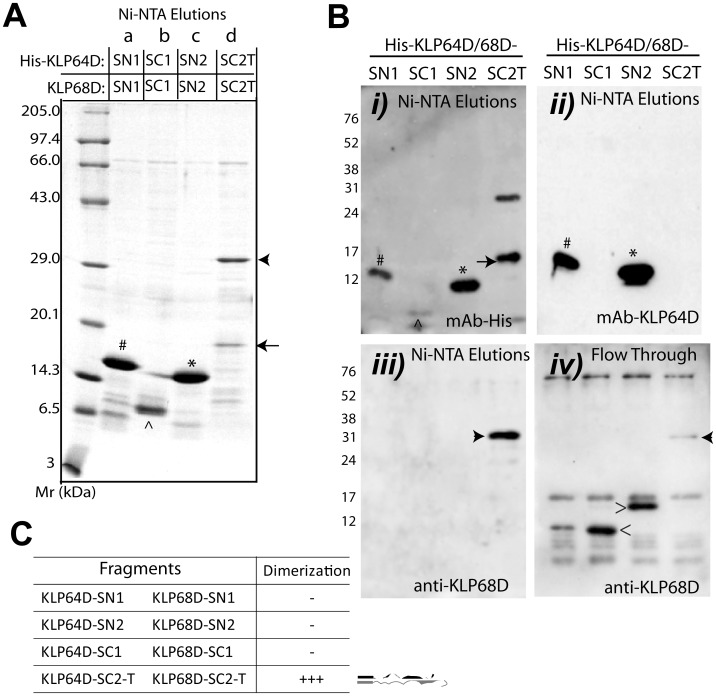
Combinatorial expressions and co-purification analysis of kinesin-II stalk fragments.A) Extracts of E. coli coexpressing, a) His-KLP64D-SN1 and KLP68D-SN1, b) His-KLP64D-SC1 and KLP68D-SC1, c) His-KLP64D-SN2 and KLP68D-SN2, and d) His-KLP64D-SC2-T along with KLP68D-SC2-T, were purified by Ni-NTA chromatography and separated by SDS-PAGE and stained with coomassie brilliant blue. B) Western blots of similar gels, as shown in (A), were stained with mAb-His (i), mAb-KLP64D (ii), and anti-KLP68D (iii), respectively. The unbound (flow through) fractions were blotted and stained with anti-KLP68D (iv). Bands corresponding to the expected sizes of His-KLP64D–SN1 (#),-SC1 (∧), -SN2 (*), and –SC2-T (arrow), as well as the KLP68D-SC1 (<), -SN2 (>) and SC2-T (arrowhead), are marked in the figures. In a separate study, mAb-KLP64D was found to stain the KLP64D-SN1 and –SN2 but not the C-terminal fragments, which is further confirmed by this data. C) Summary of the pull down results of the stalk fragments. Heterodimer formation is represented by ‘+’ and, ‘–‘ denotes absence of heterodimer formation. Cartoon next to the table represents the stalk fragments that form heterodimer.